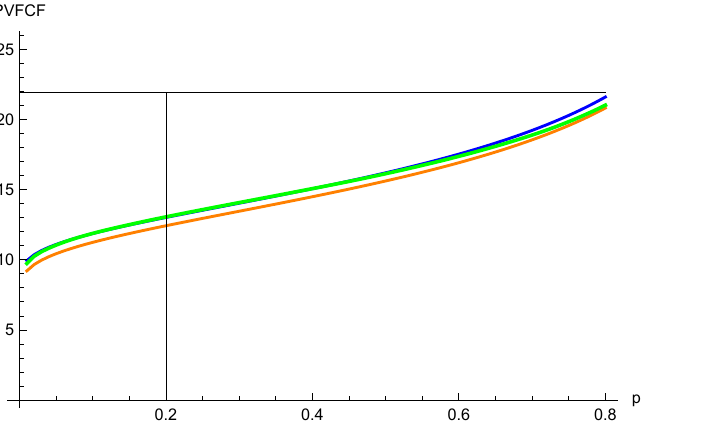
Figure 7. Partial expectation of S (thick green), S l (blue), and S u (orange), for different p . In both these graphs, the orange line is S u , the blue line is S l , and the thicker green line is S . The partial expectation graphs are nicely ordered, as expected. This is